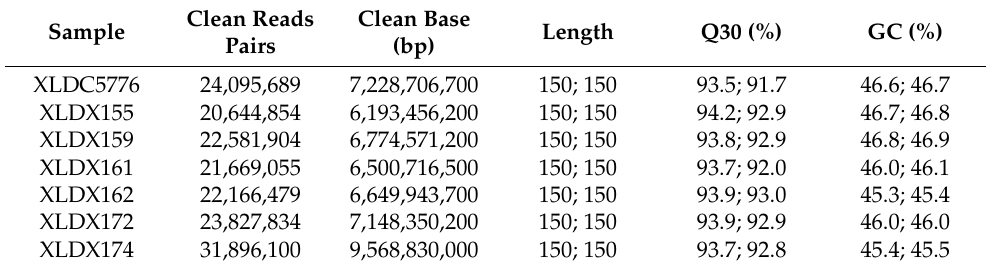
Table 2. Quality assessment of the sequencing data.